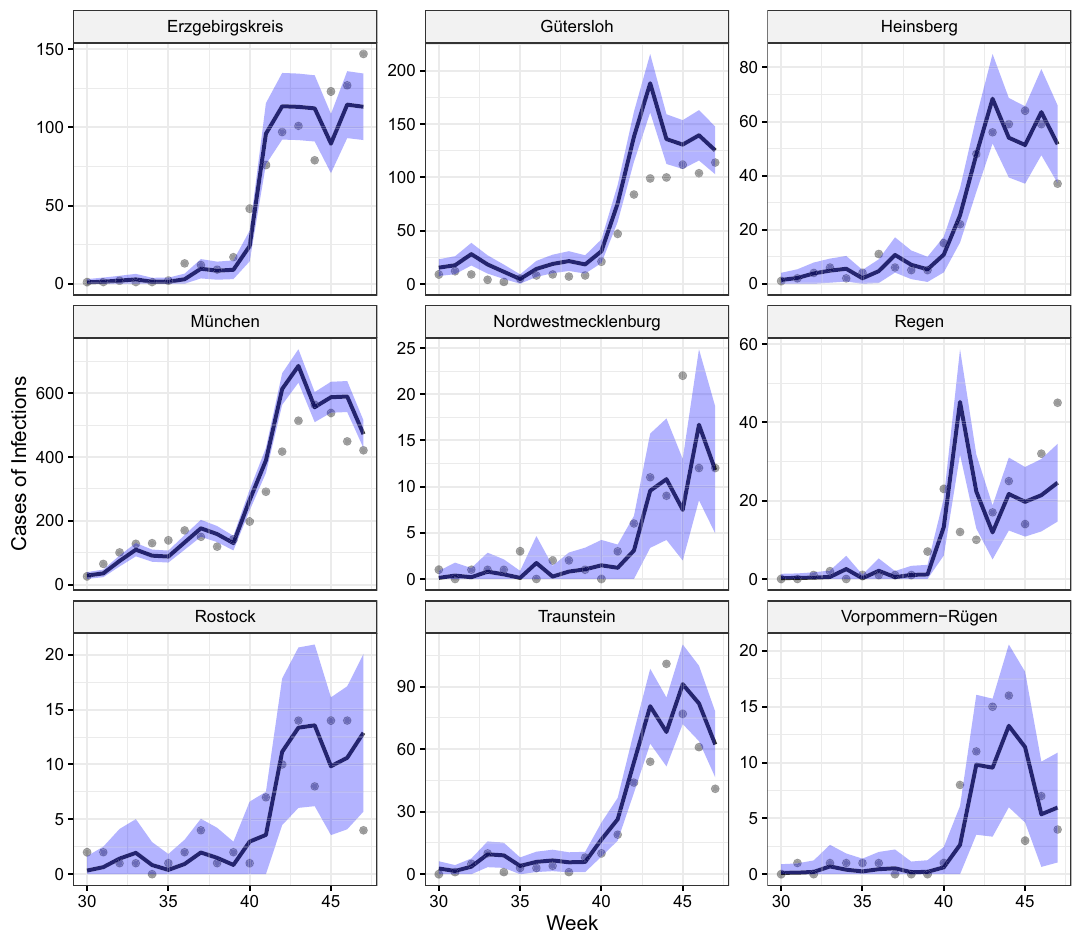
Figure 10. Prediction intervals for age group 35–59 and gender female and selected districts (facets) in Germany. For the different forecast weeks (x-axis) the true number of infections are visualized by points and contrasted with the model’s prediction (black line) and the prediction interval (shaded purple